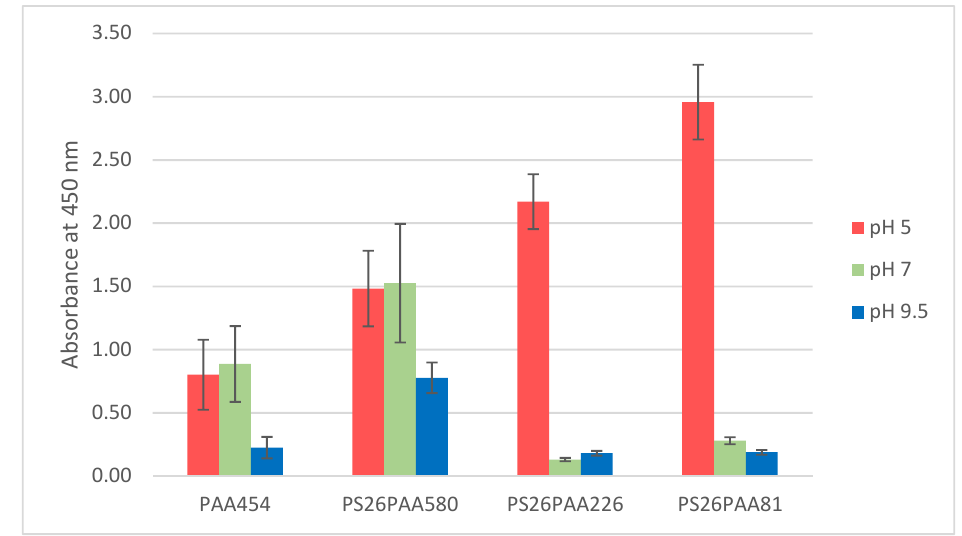
Figure 3. Absorbance values at 450 nm recorded from different polymer dispersions at three diverse pHs.